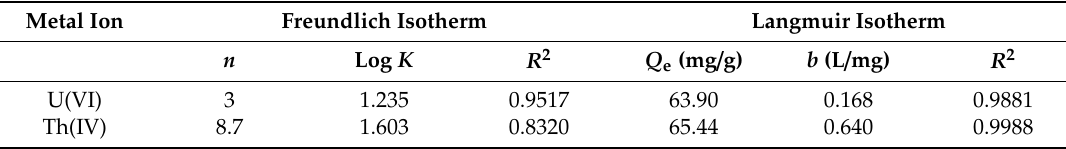
Table 2. Isotherms parameters and values of linear correlation factors ( R 2 ) for sorption of U(VI) and Th(IV) ions onto